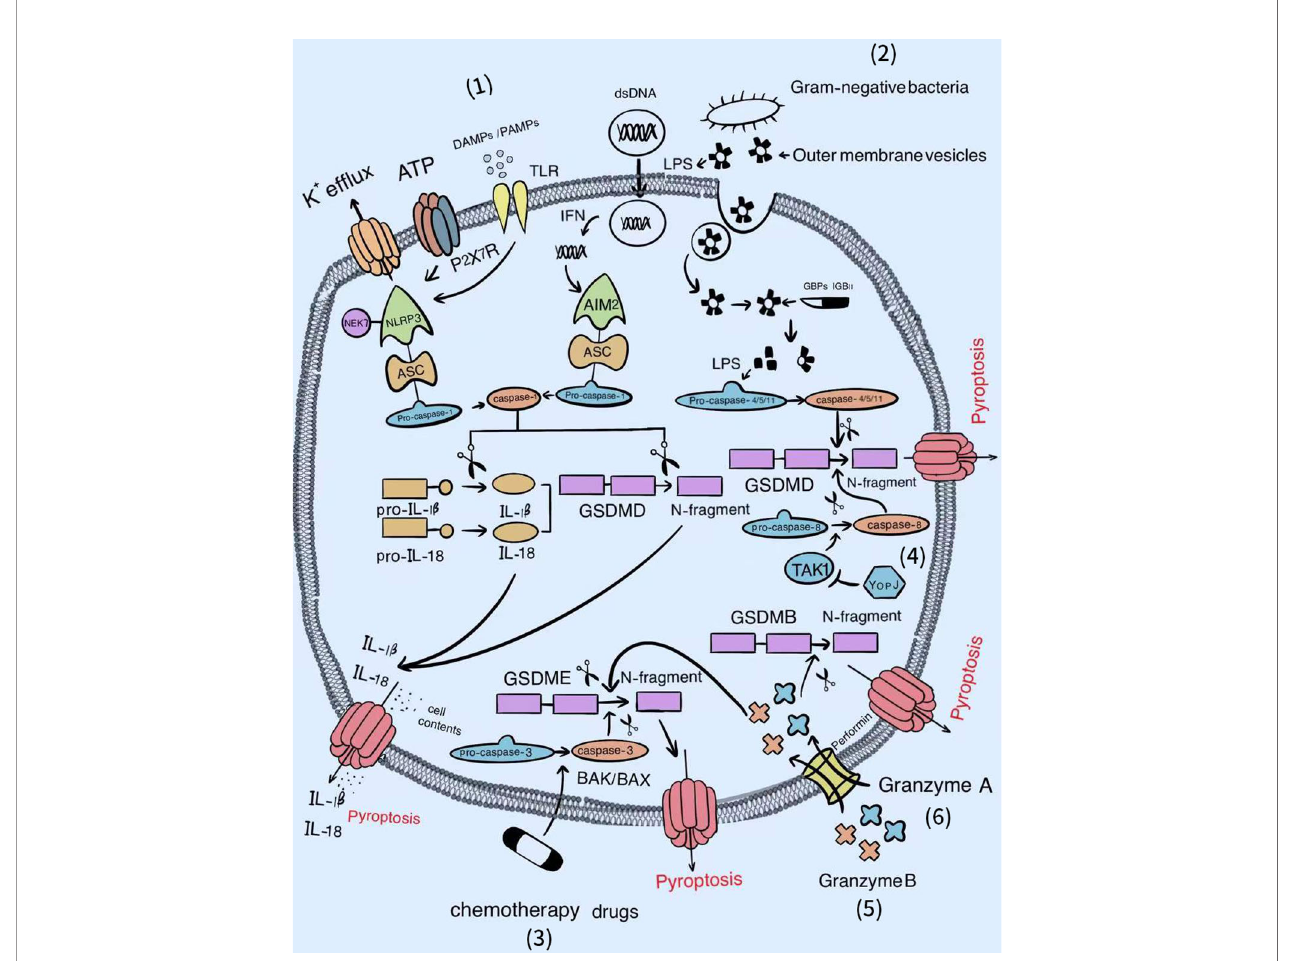
FIGURE 1 | The signal pathways of pyroptosis. Various factors can activate the gasdermin famliy to trigger pyroptosis. (1) Classical in fl ammasomes/caspase-1/ GSDMD-dependent pyroptotic pathway. (2) LPS/caspase-4, 5, or 11/GSDMD-dependent pyroptotic pathway. (3) Chemotherapy drugs/BAK/BAX/caspase-3/ GSDME-dependent pyroptotic pathway. (4) YopJ/TAK1/caspase-8/GSDMD-dependent pyroptotic pathway. (5) Granzyme B/GSDME-dependent pyroptotic pathway. (6) Granzyme A/GSDMB-dependent pyroptotic